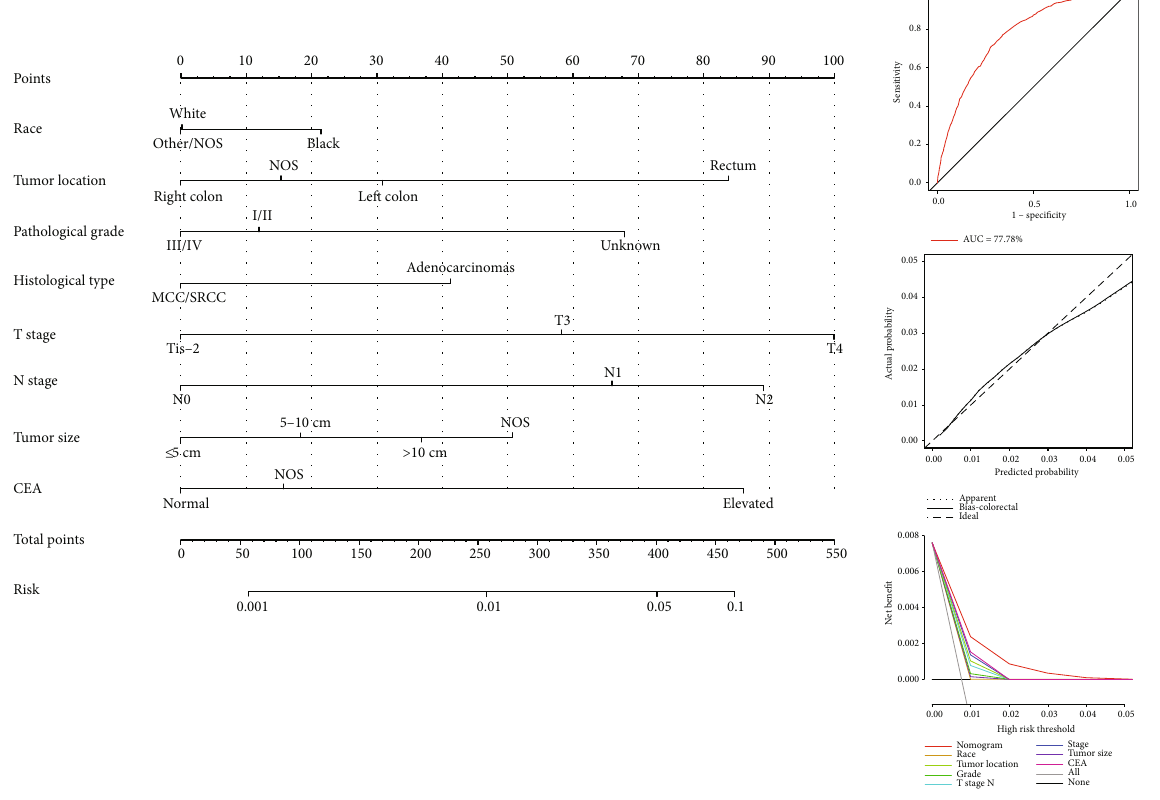
Figure 1: The weight of each independent predictor of